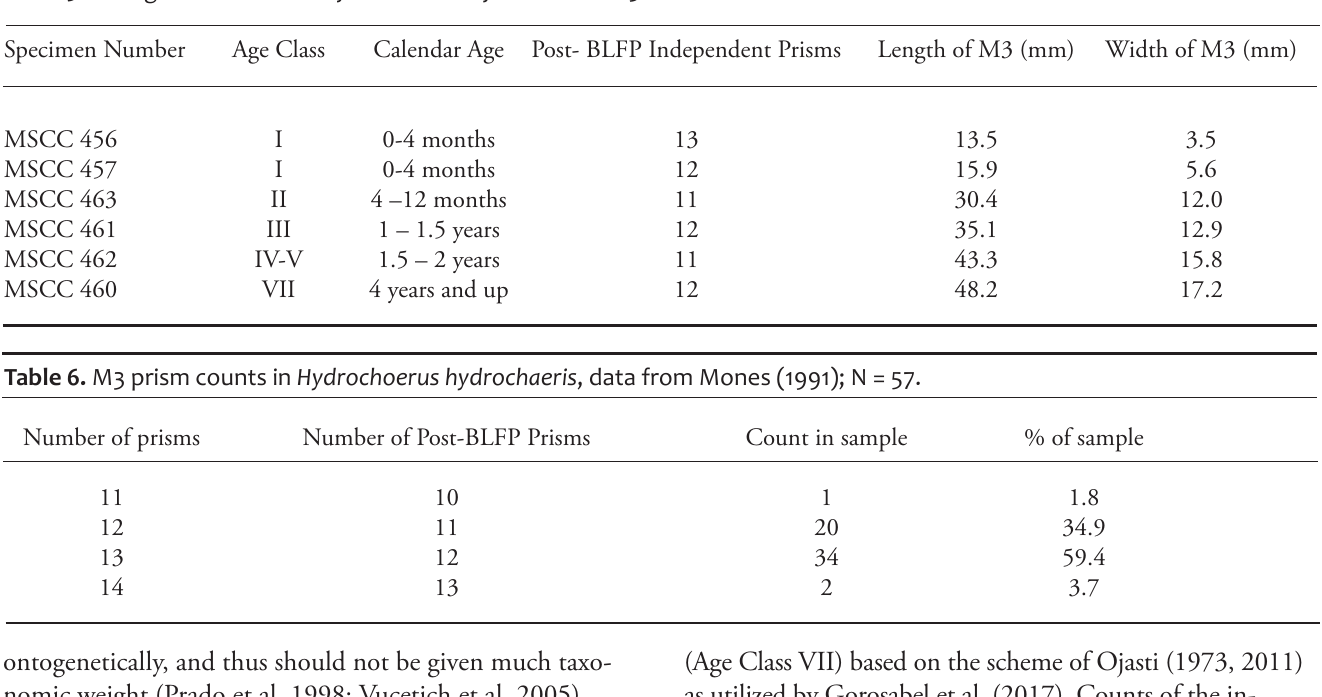
Table 5. Ontogenetic series of Hydrochoerus hydrochaeris M3s.